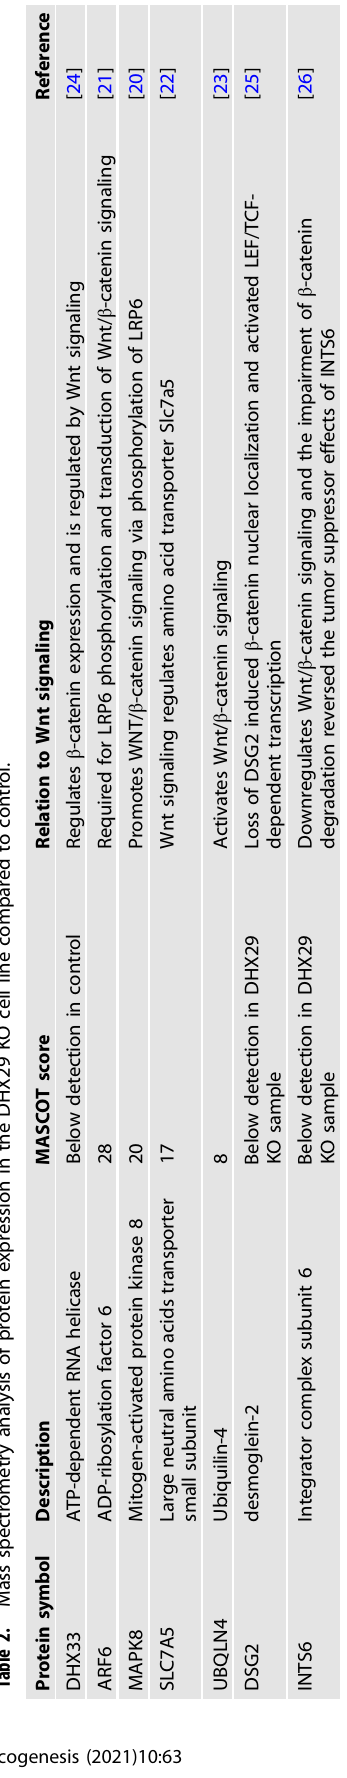
with 4% paraformaldehyde for 20 min. After three PBS washes, the fi xed cells were permeabilized with 0.1% Triton X-100 for 10 min and blocked with bovine serum albumin for 1 h. Cells were then incubated at room temperature for 1 h with the primary antibodies and then following three PBS washes were incubated for an additional hour with the secondary antibody. Cell nuclei were stained with 4 – 6 ′ diamidino-2 phenylindole (DAPI, Sigma). Cells were visualized using a confocal laser microscope (LSM800, Carl Zeiss). Western blot analysis Total protein was harvested from cells with lysis buffer (100 mM NaCl, 50 mM Tris, pH 7.5, 1% Triton X-100, 2 mM EDTA) containing protease inhibitor cocktail (Sigma). Extracts were clari fi ed by centrifugation at 12,000 × g for 15 min at 4 °C. Following SDS – polyacrylamide gel T a